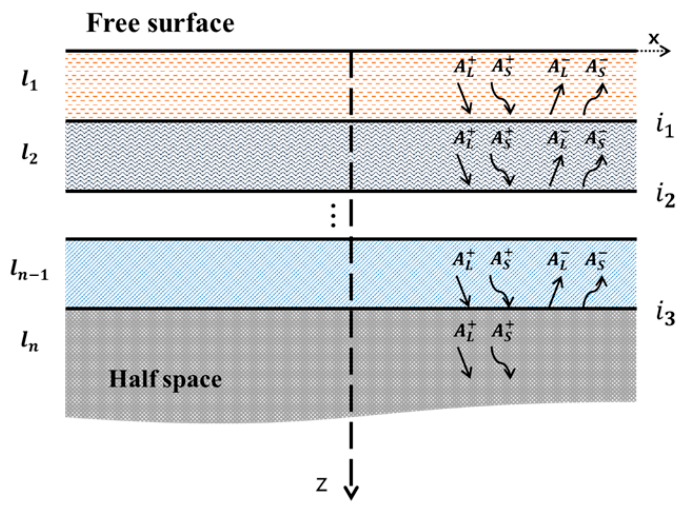
Figure 1. Schematic diagram of SAW propagating in multi-layer thin films. Here, k x and k z are the wavenumber in the x -direction and z -direction, respectively, A L is the amplitude of the longitudinal wave, and A S is the amplitude of the transverse wave. In the Cartesian coordinate system, the relationship between the displacement, stress, and amplitude in the propagation direction ( x -axis) and the depth direction ( z -axis) is as shown in Equation (2) below.